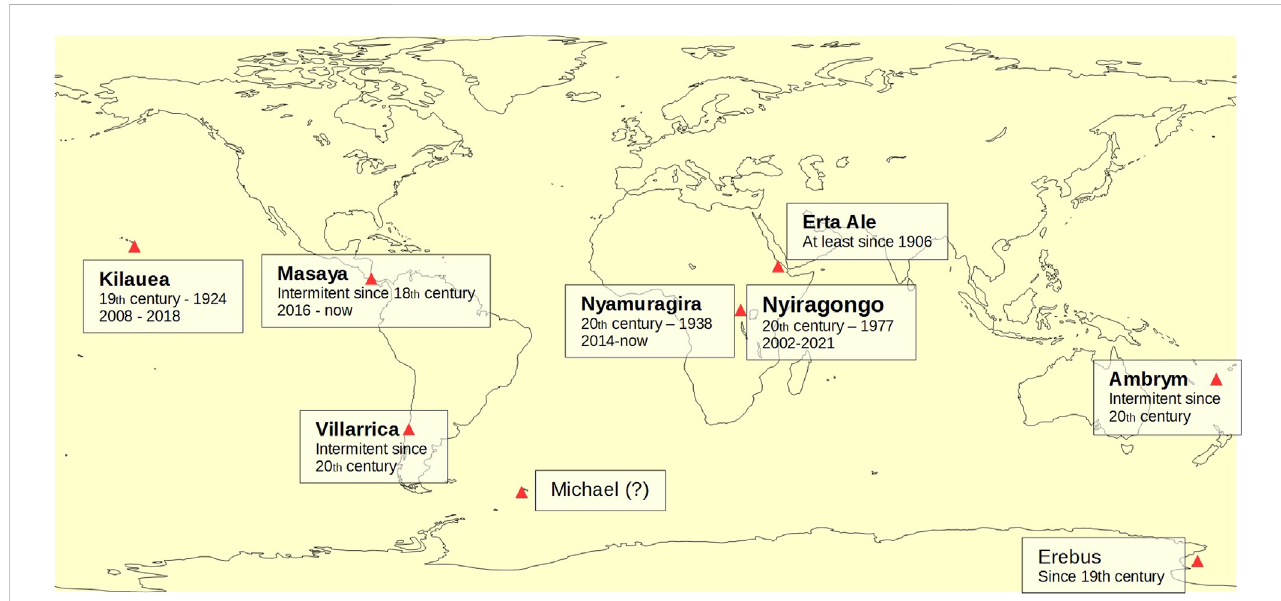
FIGURE 1 Location of the volcanoes that are hosting or have recently hosted a lava lake. Volcanoes in bold are discussed in this study. The periods of existence of each lava lake are mentioned when known.